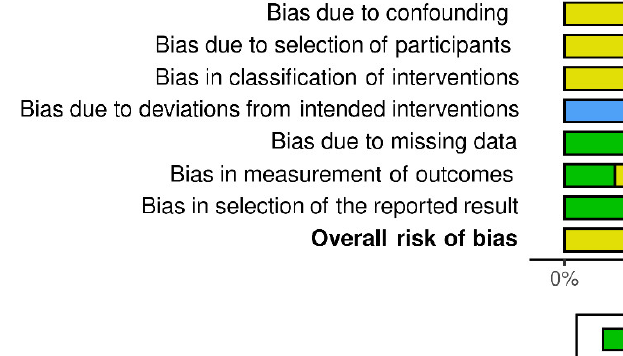
Figure 3. ROBINS-I risk of bias assessment graph.